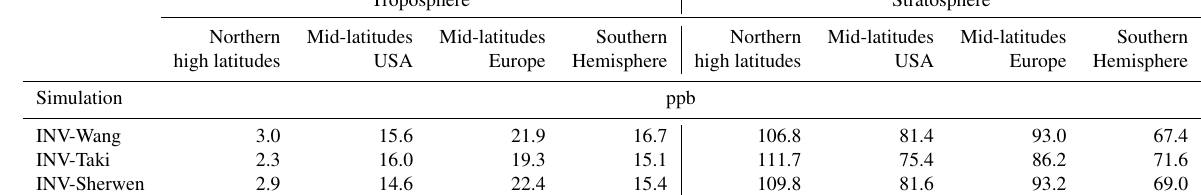
Table 5. RMSD between simulated and observed CH 4 vertical profiles in the troposphere and stratosphere for different regions of the world. Troposphere Stratosphere Northern Mid-latitudes Mid-latitudes Southern Northern Mid-latitudes Mid-latitudes Southern high latitudes USA Europe Hemisphere high latitudes USA Europe Hemisphere Simulation ppb INV-Wang